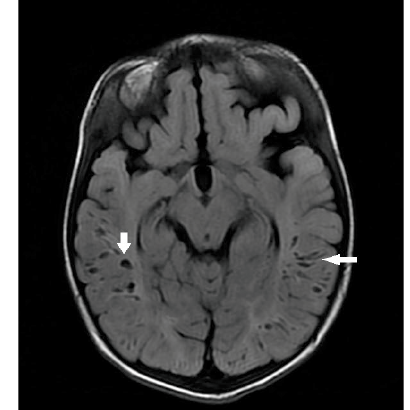
Fig. 3. Axial T2 FLAIR (TR/TE/TI, 9502/125/2250 ms) image at the level of the temporal lobes shows the cribriform pattern (arrows) of enlarged perivascular spaces in the deep white matter.